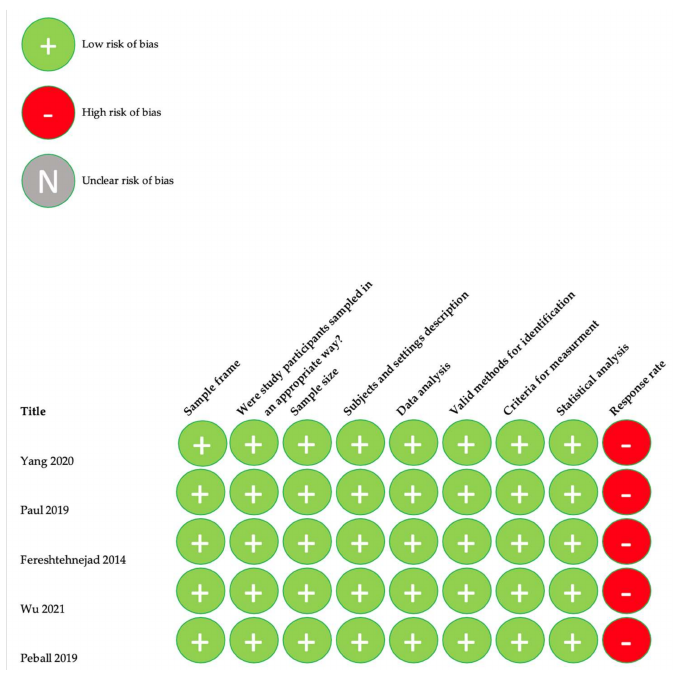
Figure 2. Quality assessment for prevalence studies [10–14].